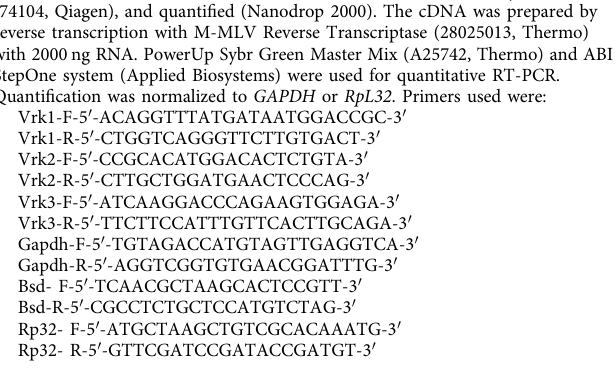
rP298.nlacZ embryos. Fusion Index = #lacZ nuclei experimental/#lacZ nuclei control.